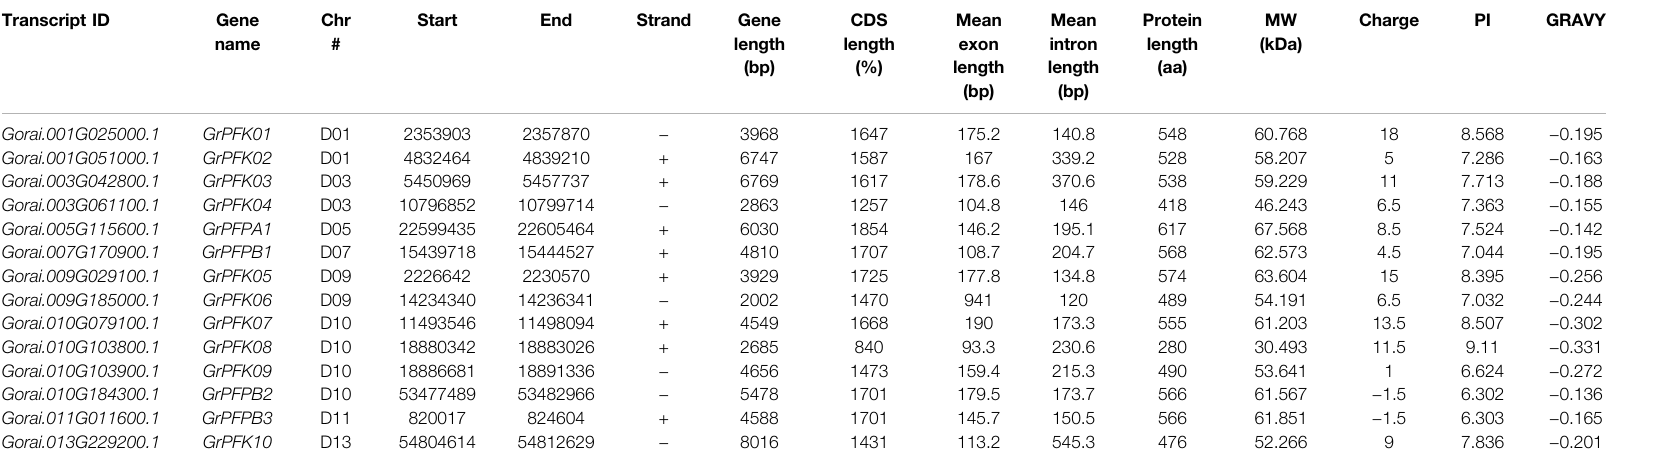
TABLE 3 | Transcript and physiochemical features of PFK genes in G. raimondii